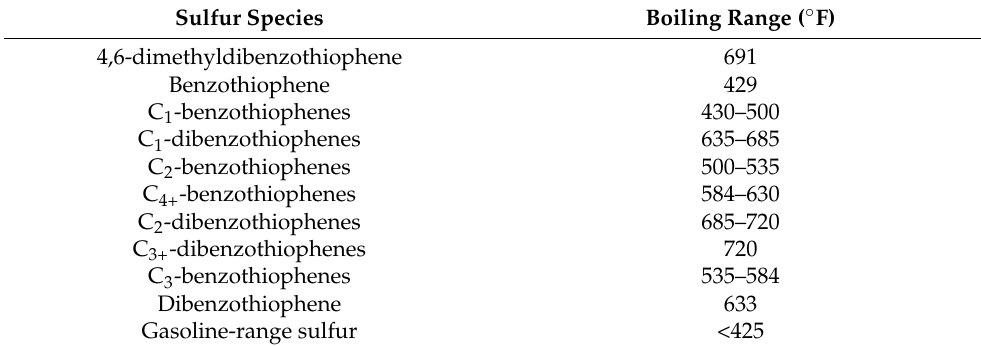
Table 2. Aromatic sulfur species found in petroleum and their boiling point. Sulfur